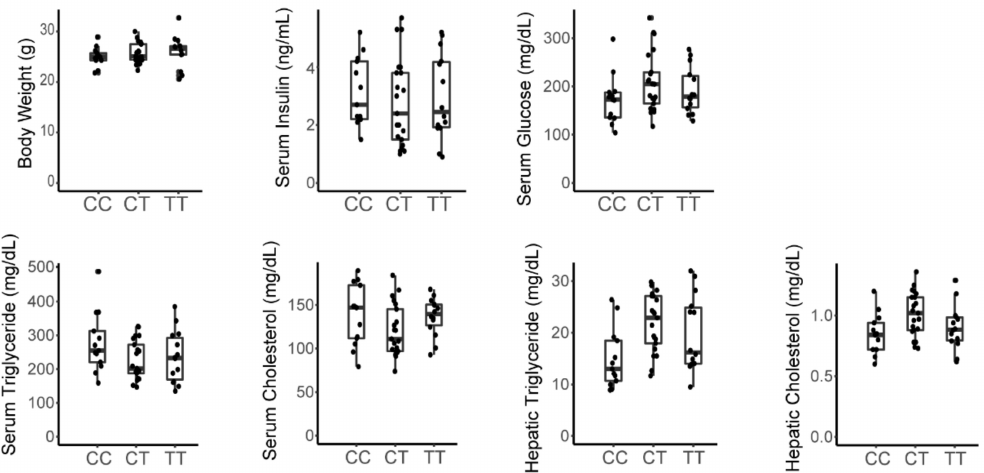
Figure 3. Srebf1 haplotypes do not associate with metabolic traits in male fructose fed F2 mice. Genotyping performed for rs26973133 [C/T]. CC = homozygous C3H; CT = heterozygous; TT = homozygous C57.